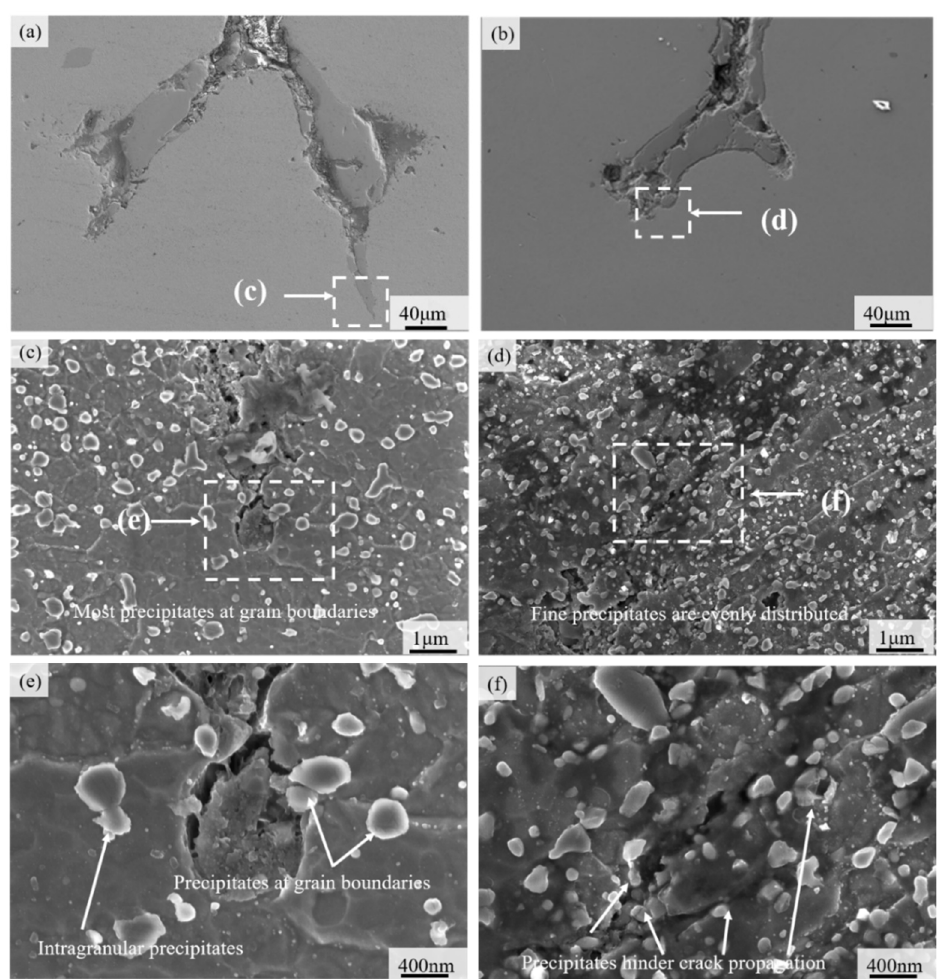
Figure 8. The topography of crack tip: ( a ) crack tip morphology of material ZG1; ( b ) crack tip mor- phology of material ZG2; ( c ) crack tip of material ZG1; ( d ) crack tip of material ZG2; ( e ) precipitated phase near the crack tip of ZG1; ( f ) precipitated phase near the crack tip of ZG2.